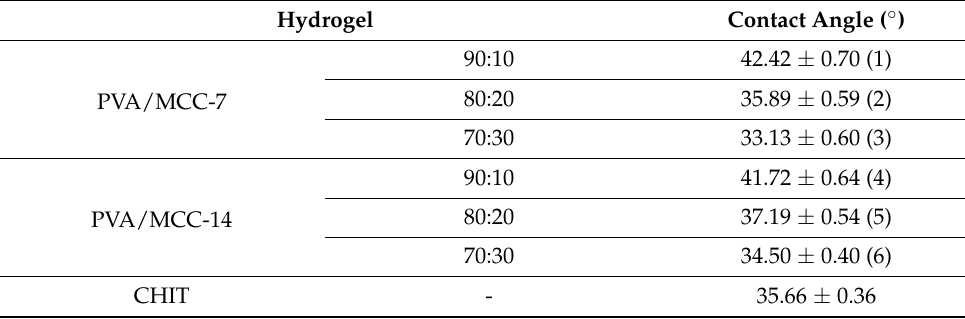
Table 4. Contact angle measurements (mean ± SE; n =